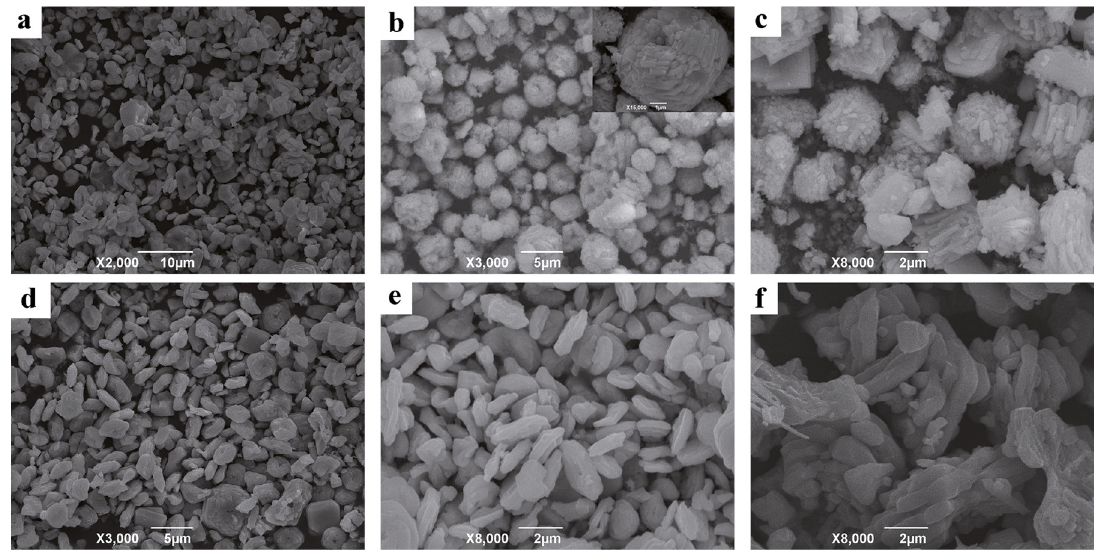
Figure 1: XRD pattern of the as-prepared CdMoO at pH=5 and 180 o C, and (d) pH series at 70 o C for 24 h.